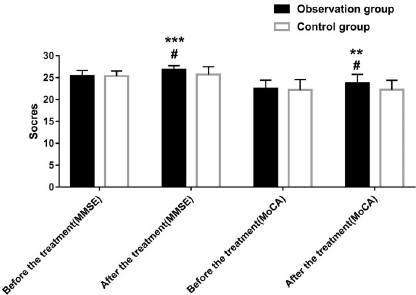
Figure 1. Comparison of cognitive scores after treatment. Data are reported as means ± SD. **P o 0.01, ***P o 0.001 compared with the control group; # P o 0.05 compared with before treatment (independent-sample t -test and the paired-sample t -test). MMSE: mini-mental state examination; MoCA: Montreal Cognitive